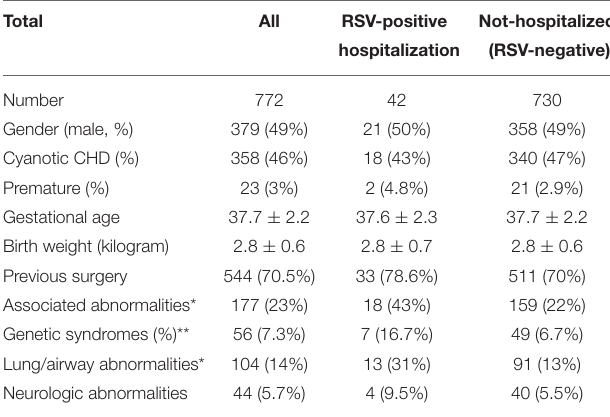
TABLE 1 | Basic demographics of patients with hemodynamically significant congenital heart disease (CHD) ( n =